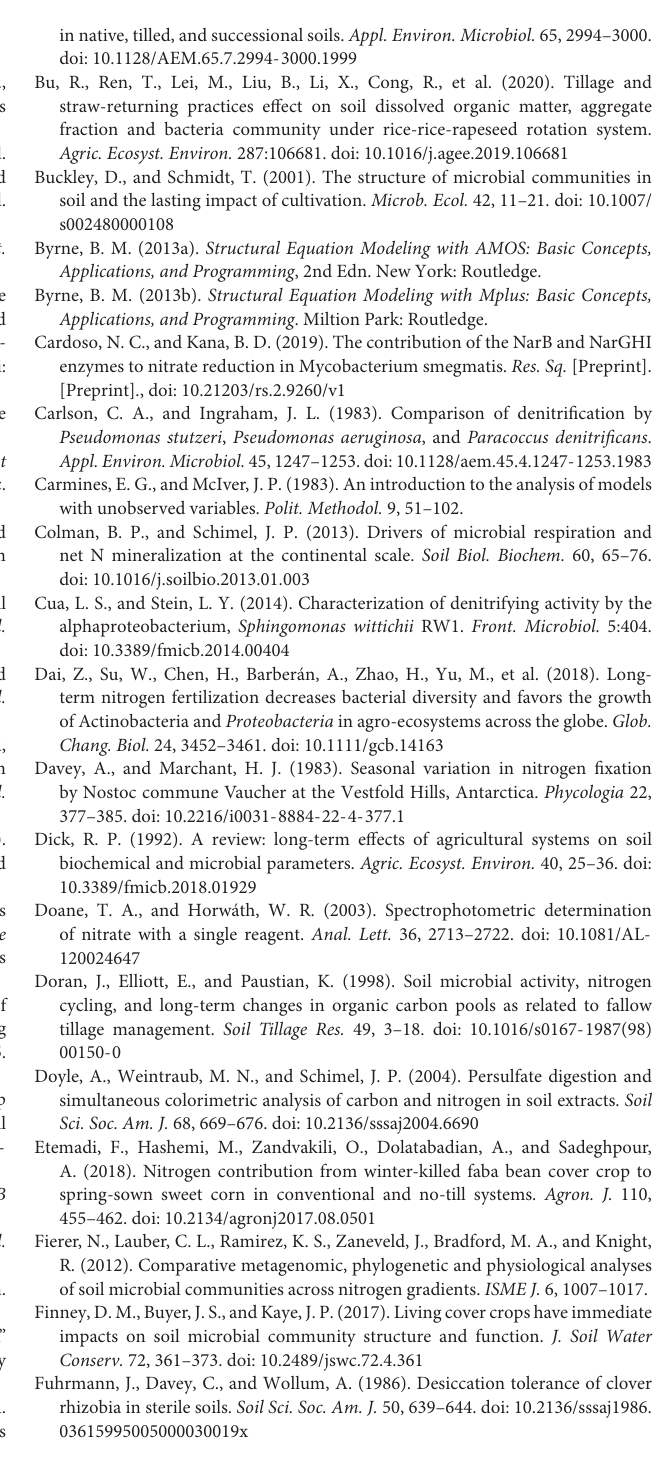
Supplementary Table 3 | Standard total effect for SEM. Supplementary Table 4 | Coding for sample ID. Supplementary Table 5 | The data for